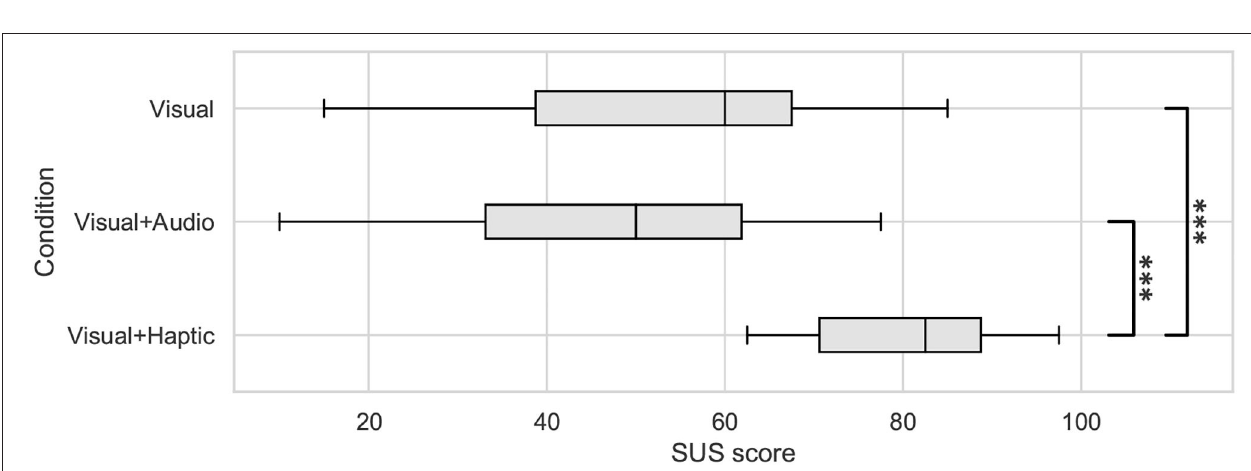
FIGURE 10 | Box plots of SUS scores in each condition. *** p <